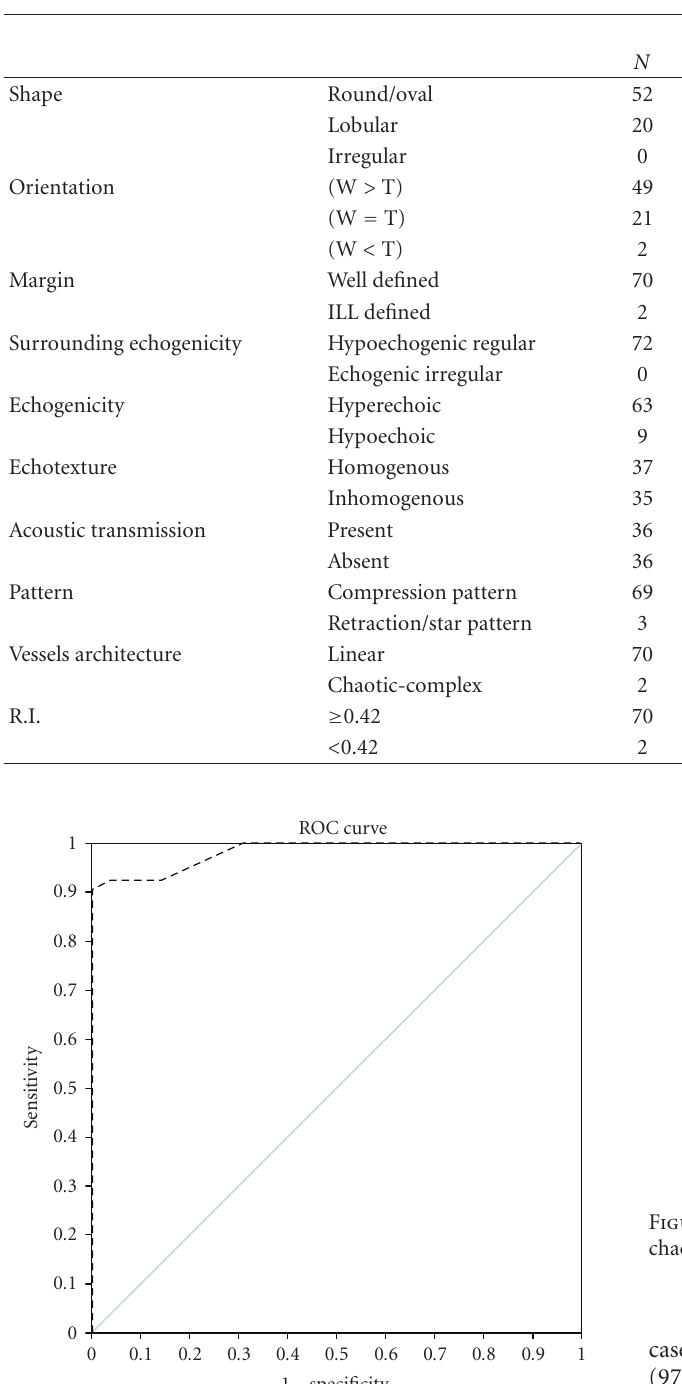
Table 3: 3D outcome according to the sonographic criteria used in our breast tumor patients.